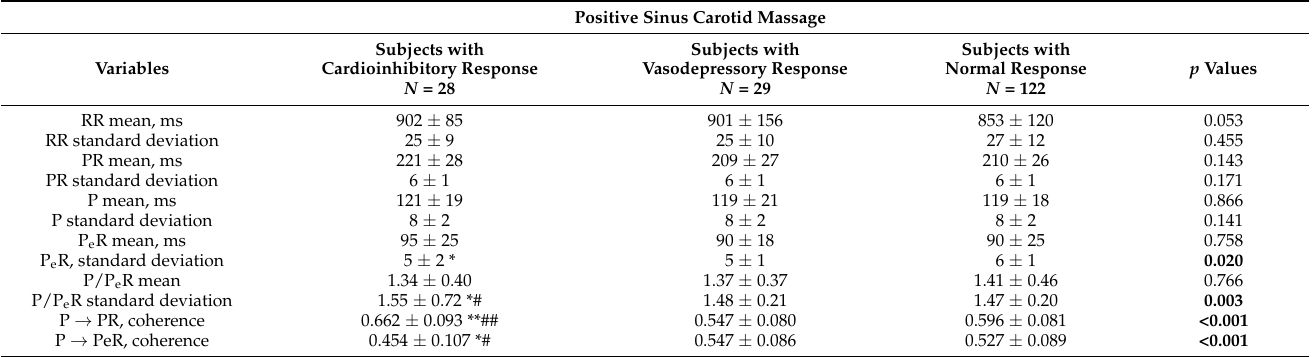
Table 4. 5 Minutes of ECG and Pressure Data during Controlled Breathing.